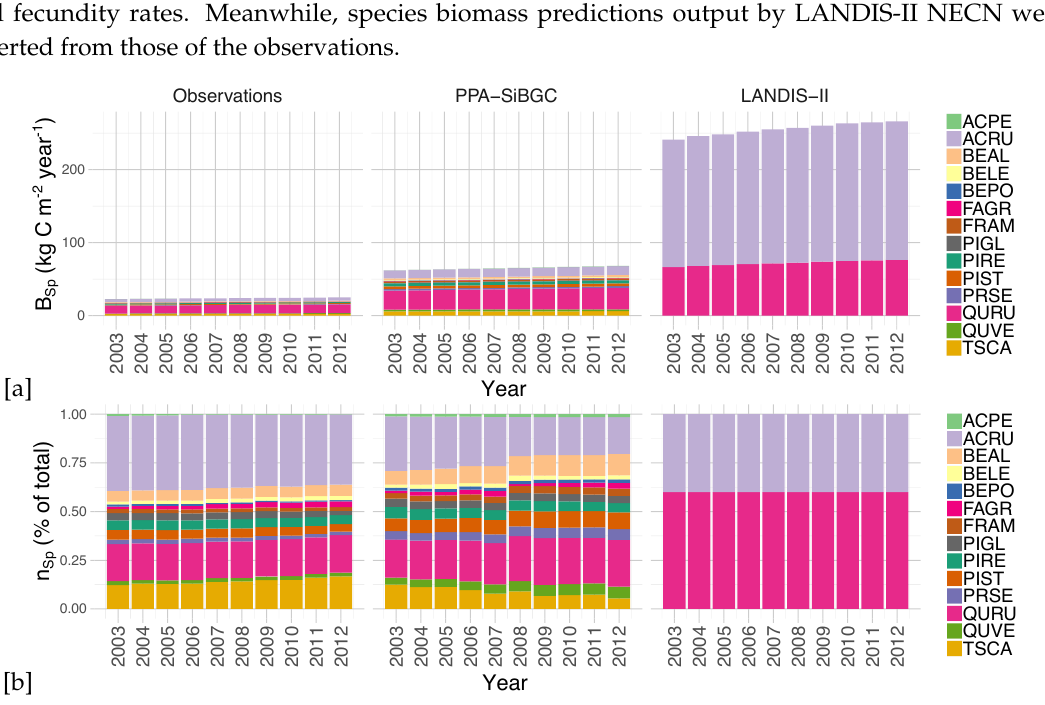
Figure 7. HF-EMS: Simulated and observed species aboveground biomass and relative abundance; ( a ) = biomass; ( b ) = abundance; left = observations, middle = PPA-SiBGC, right = LANDIS-II NECN; note that different scales are used for